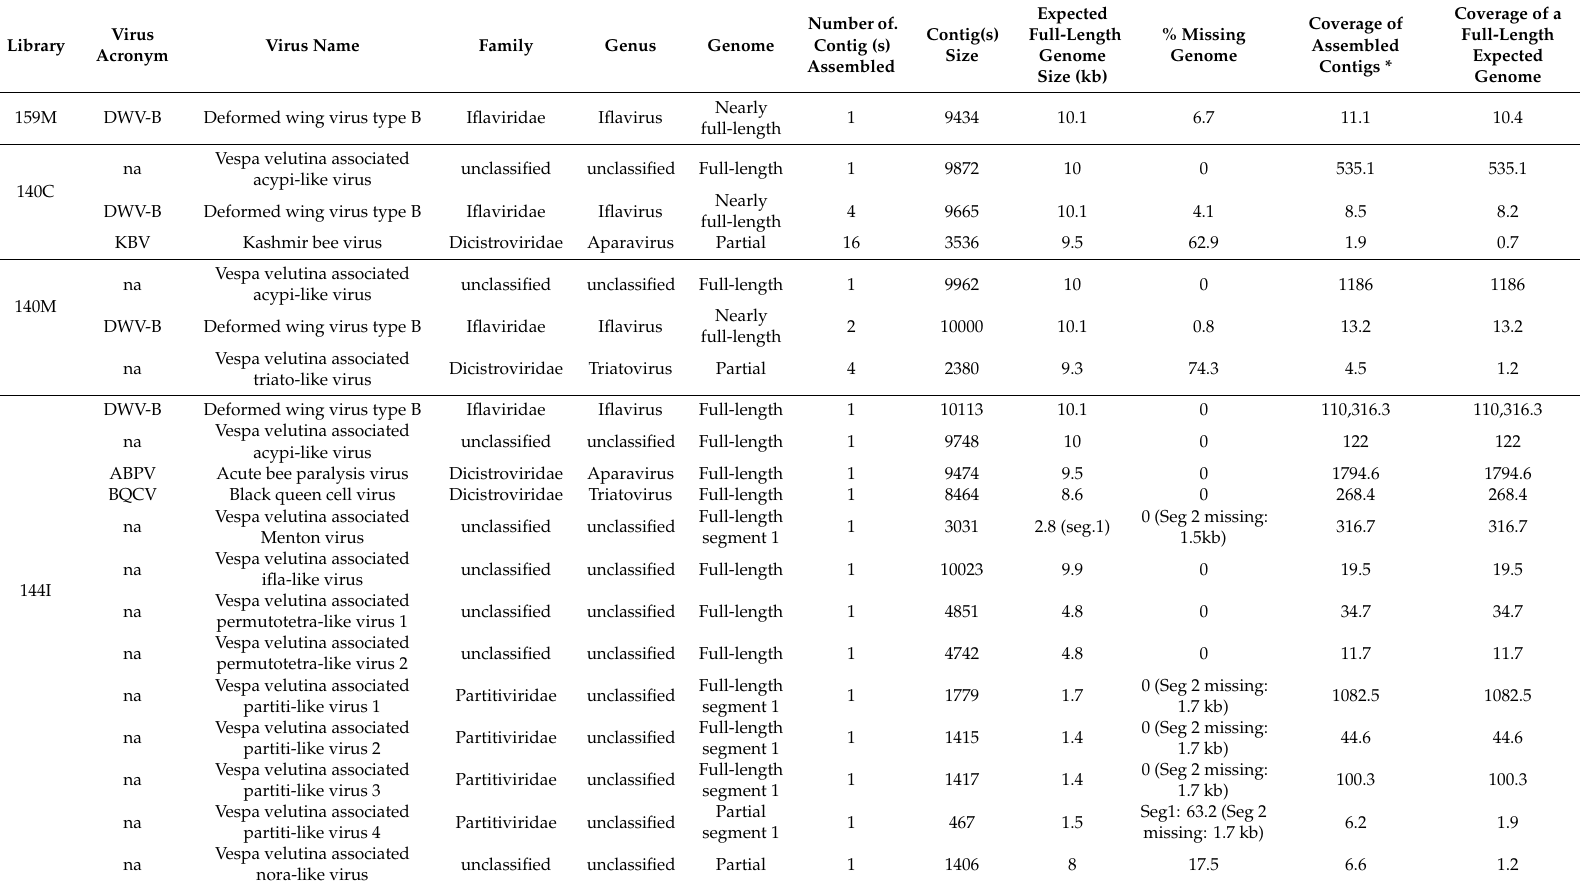
Table 2. Taxonomy and genomic characteristics of viruses detected in hornet